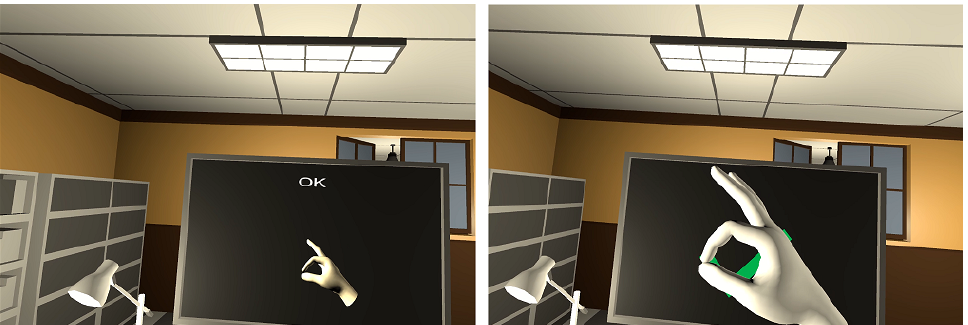
Figure 7. Experiment part one. A gesture is displayed to the participant ( left ) that should then be imitated ( right ). This test is to ensure that gestures can be recognized